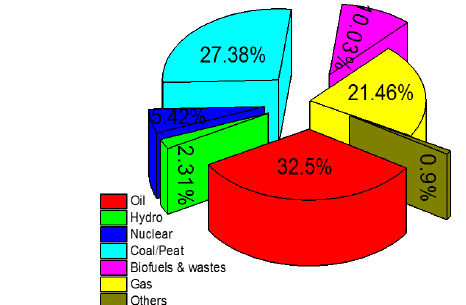
Fig.1: World fuels share in Total Primary Energy Supplies